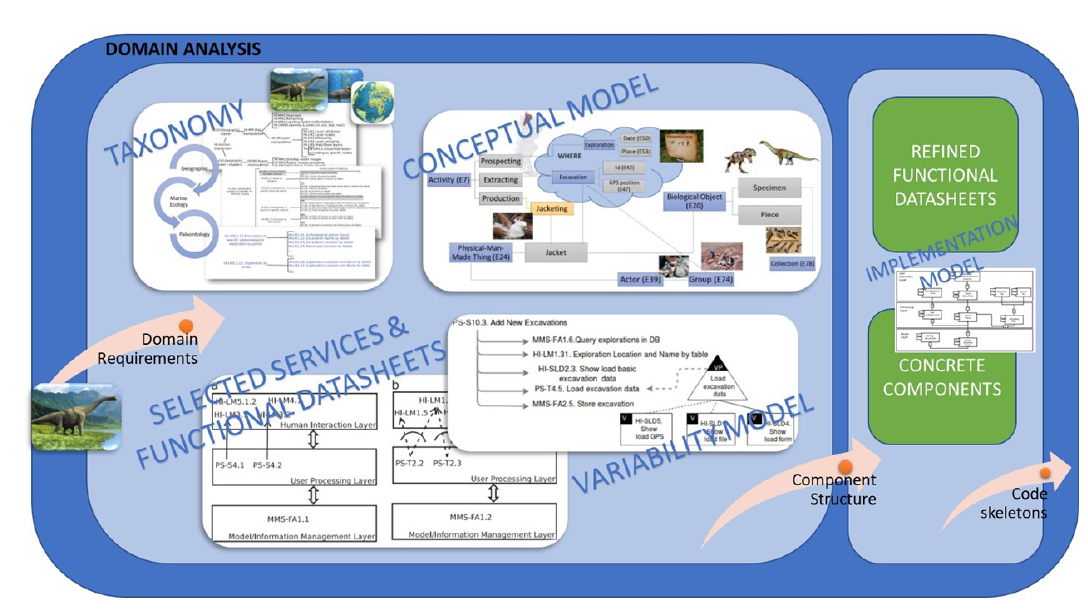
Figure 4. Overview of the taxonomy-oriented domain